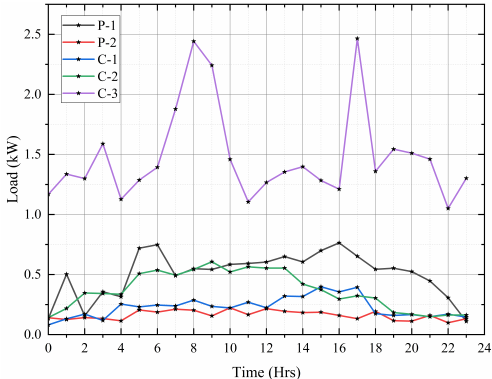
Figure 3. Prosumer and consumer load profile.